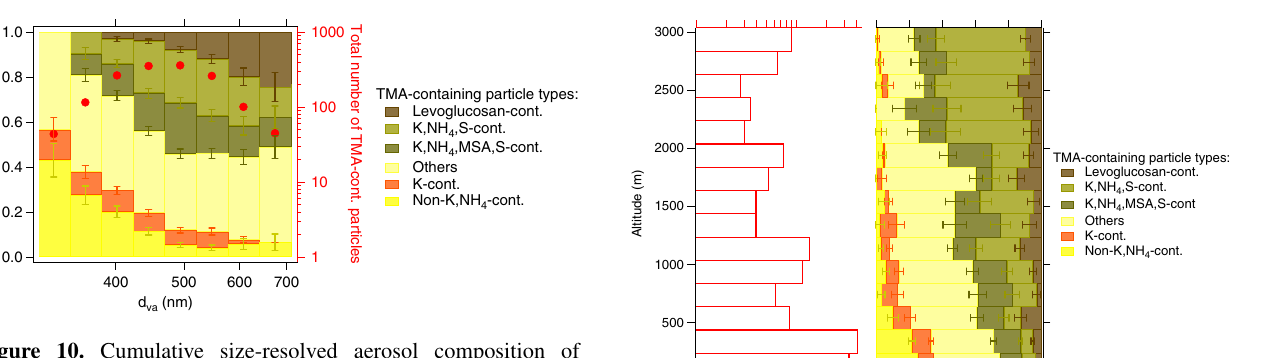
Figure 10. Cumulative size-resolved aerosol composition of TMA-containing particle sub-types (normalized to the total number of TMA-containing particles (indicated by red dots)): “K,NH 4 ,MSA,S-containing” (dark green), “K,NH 4 ,S-containing” (light green), “K-containing” (orange), “Non-K,NH 4 -containing” (yellow), “levoglucosan-containing” (brown) and “others” (light yellow).